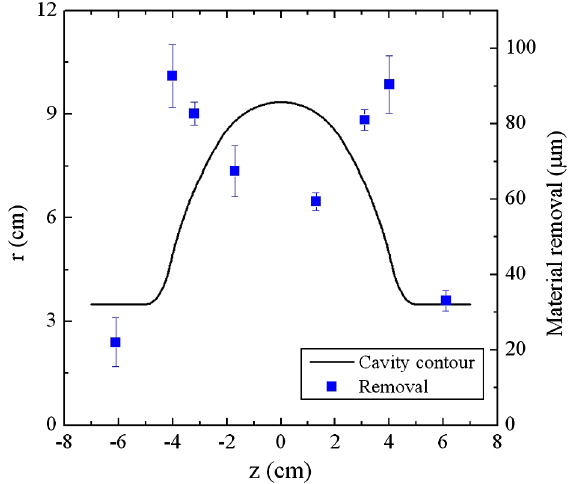
FIG. 1. Material removal by CBP measured at different loca- tions along the cavity contour r ð z Þ